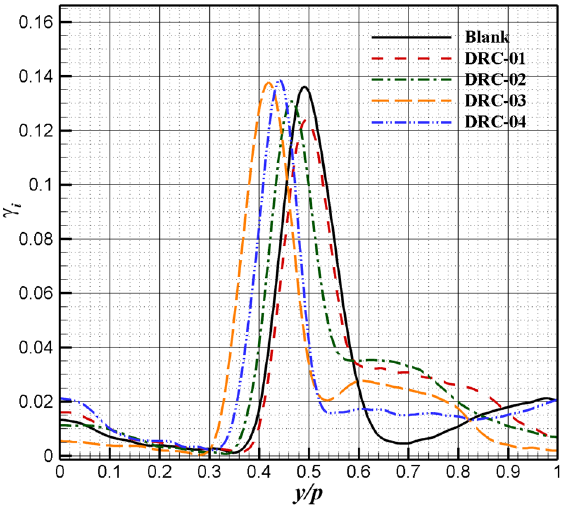
Figure 10. The pitch-wise distributions of total pressure loss coefficient with different coatings. The area-averaged total pressure loss coefficient 𝛾 and the percentage of loss reduc- tion 𝜉 of cascade with five different coatings are shown in Table 2. DRC-01 with single-